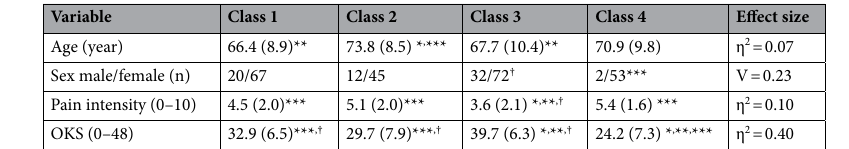
Table 4. Descriptive statistics of demographic variables and external variables. OKS Oxford Knee Score. *Indicates significant difference compared with Class 1. **Significant difference compared with Class 2. ***Significant difference compared with Class 3. † Significant difference compared with Class 4. P values of less than 0.012 for Bonferroni post hoc tests and Chi-squared test, and 0.0083 for Wilcoxon rank